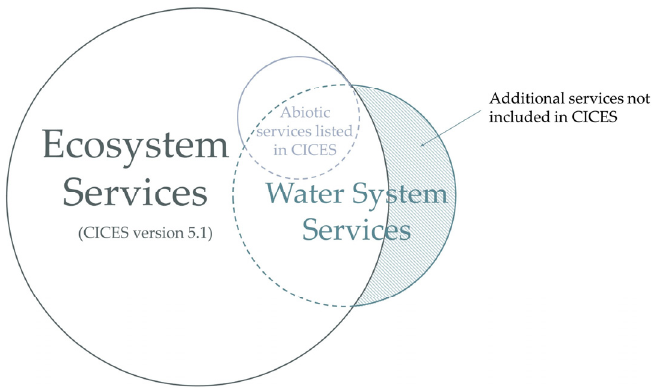
Figure 2. The relation between ecosystem services and water system services. Most water system services are ecosystem services, but additional services not included in CICES may exist depending on the type of drinking water source. Additional services can be biotic or abiotic.